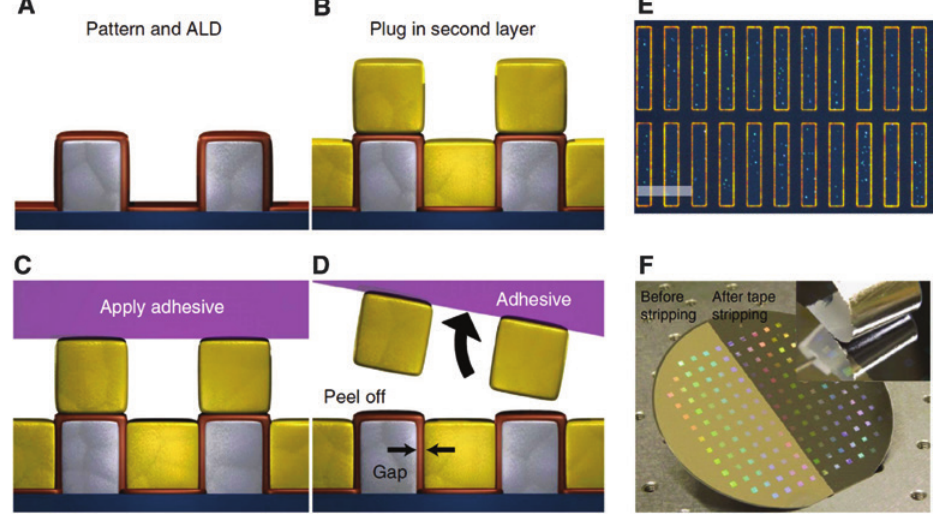
Figure 19: Wafer-scale atomic layer